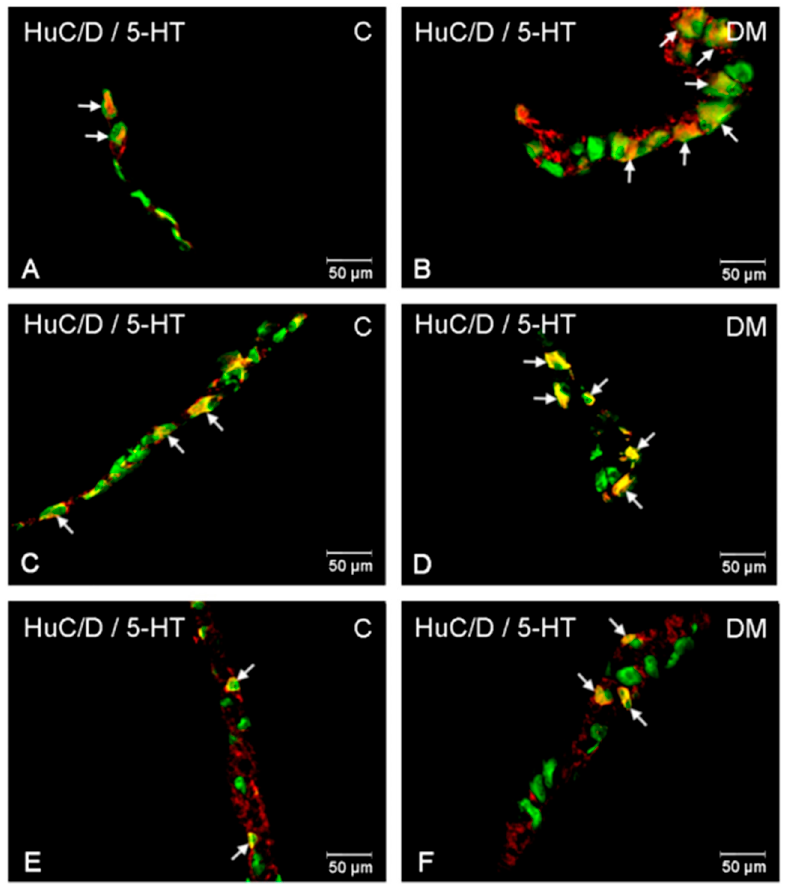
Figure 4. Immunofluorescent microphotographs showing serotonin immunoreactive perikarya in duodenum in the myenteric plexus of the control ( A ) and in experimental group ( B ); inner submucosal plexus of the control ( C ) and in experimental group ( D ); outer submucosal plexus of the control ( E ) and in the experimental group ( F ). (C)—control group; (DM)—diabetes mellitus. Photographs in the right column were created by digital superimposition of two-color channels; Hu C/D (green)- and serotonin-positive (red). The arrows indicated studied cells’